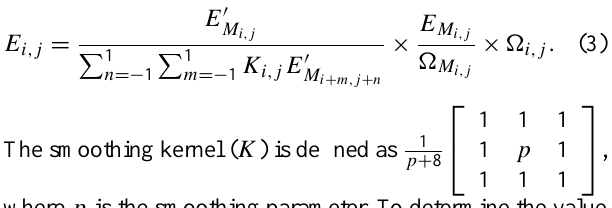
Figure 11. Seasonal variation of NO 2 mixing ratios at rural SEARCH sites for 2006–2010. Open bars represent seasonal mean NO 2 mixing ratios from in situ measurements, and solid bars repre- sent those derived from the OMI tropospheric NO 2 columns. Error bars in in situ measurements represent 10% errors in the photolytic converter measurements. Error bars in the OMI-derived surface NO 2 represent errors in retrievals including errors in the GEOS- Chem NO 2